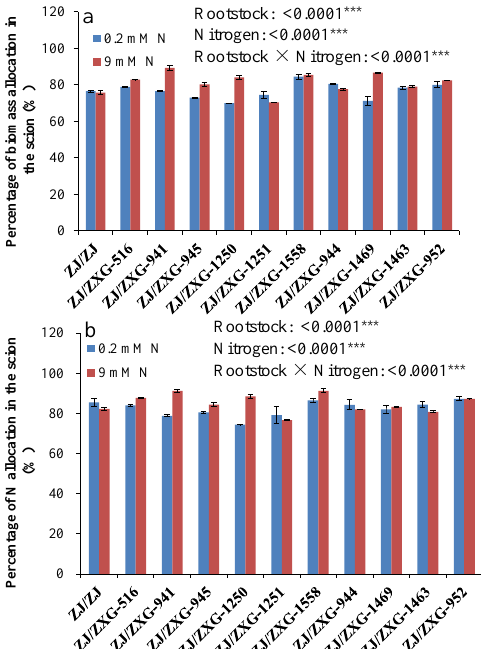
Figure 4. Percentage biomass allocation in the scion ( a ) and percentage of N allocation in the scion ( b ) of watermelon cultivar Zaojia 8424 (ZJ), self-grafted (ZJ/ZJ) and grafted onto 10 different wild watermelon rootstocks under normal (9 mM) and low (0.2 mM) N conditions. Values are means ± SE of three replicates. *** represent P ≤ 0.05.